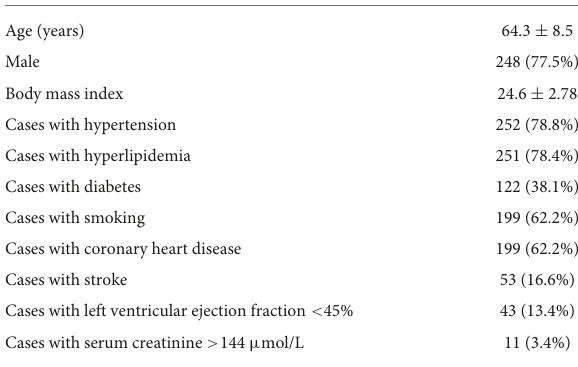
TABLE 1 General characteristics of 320 patients with supra-arch